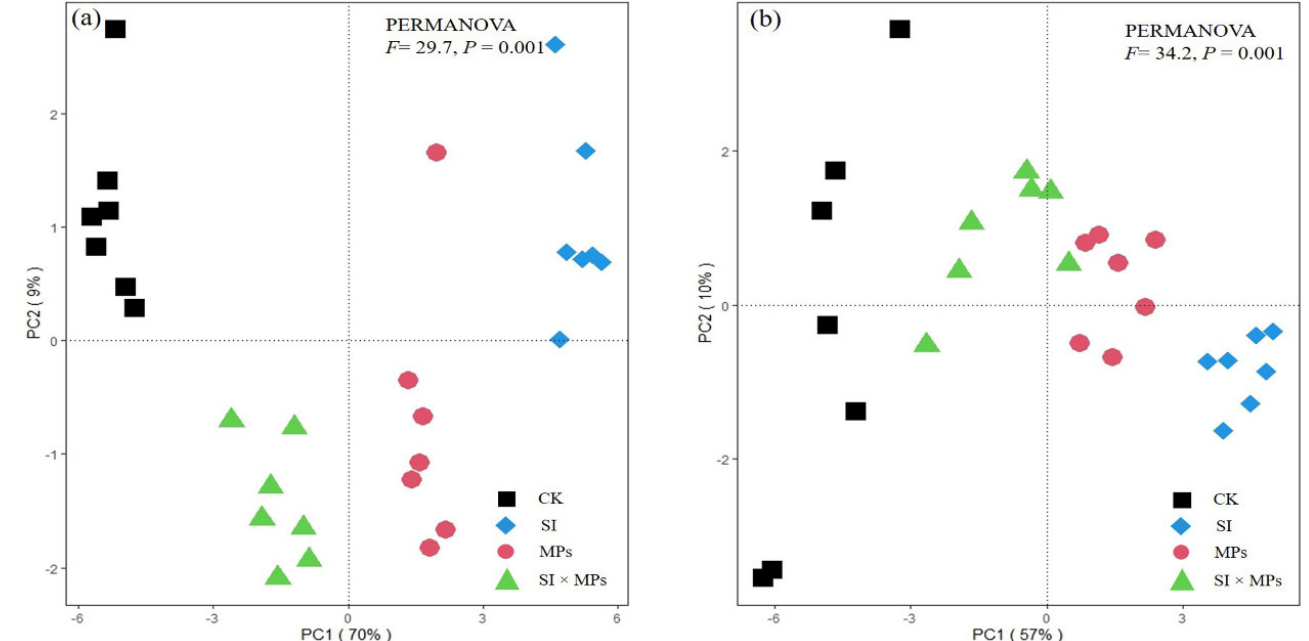
Figure 1. Principal component analysis (PCA) of all the biomass, photosynthetic parameters, and antioxidant enzymes of rice crop at the ( a ) 50th and ( b ) 80th days after transplanting. CK = control treatment; SI = Solidago canadensis L. invasion treatment; MPs = soil microplastics residual treatment; SI × MPs = combination of S. canadensis invasion treatment and soil microplastics residual treatment.